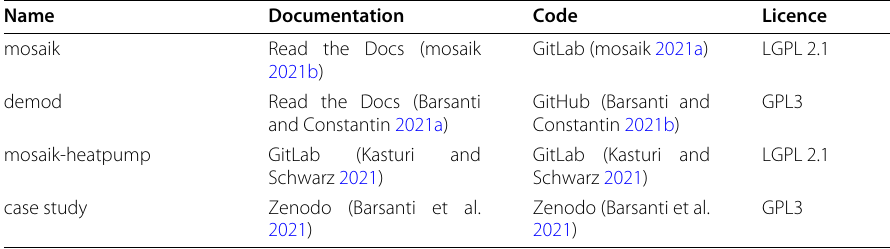
Table 2 Transparency of integrated